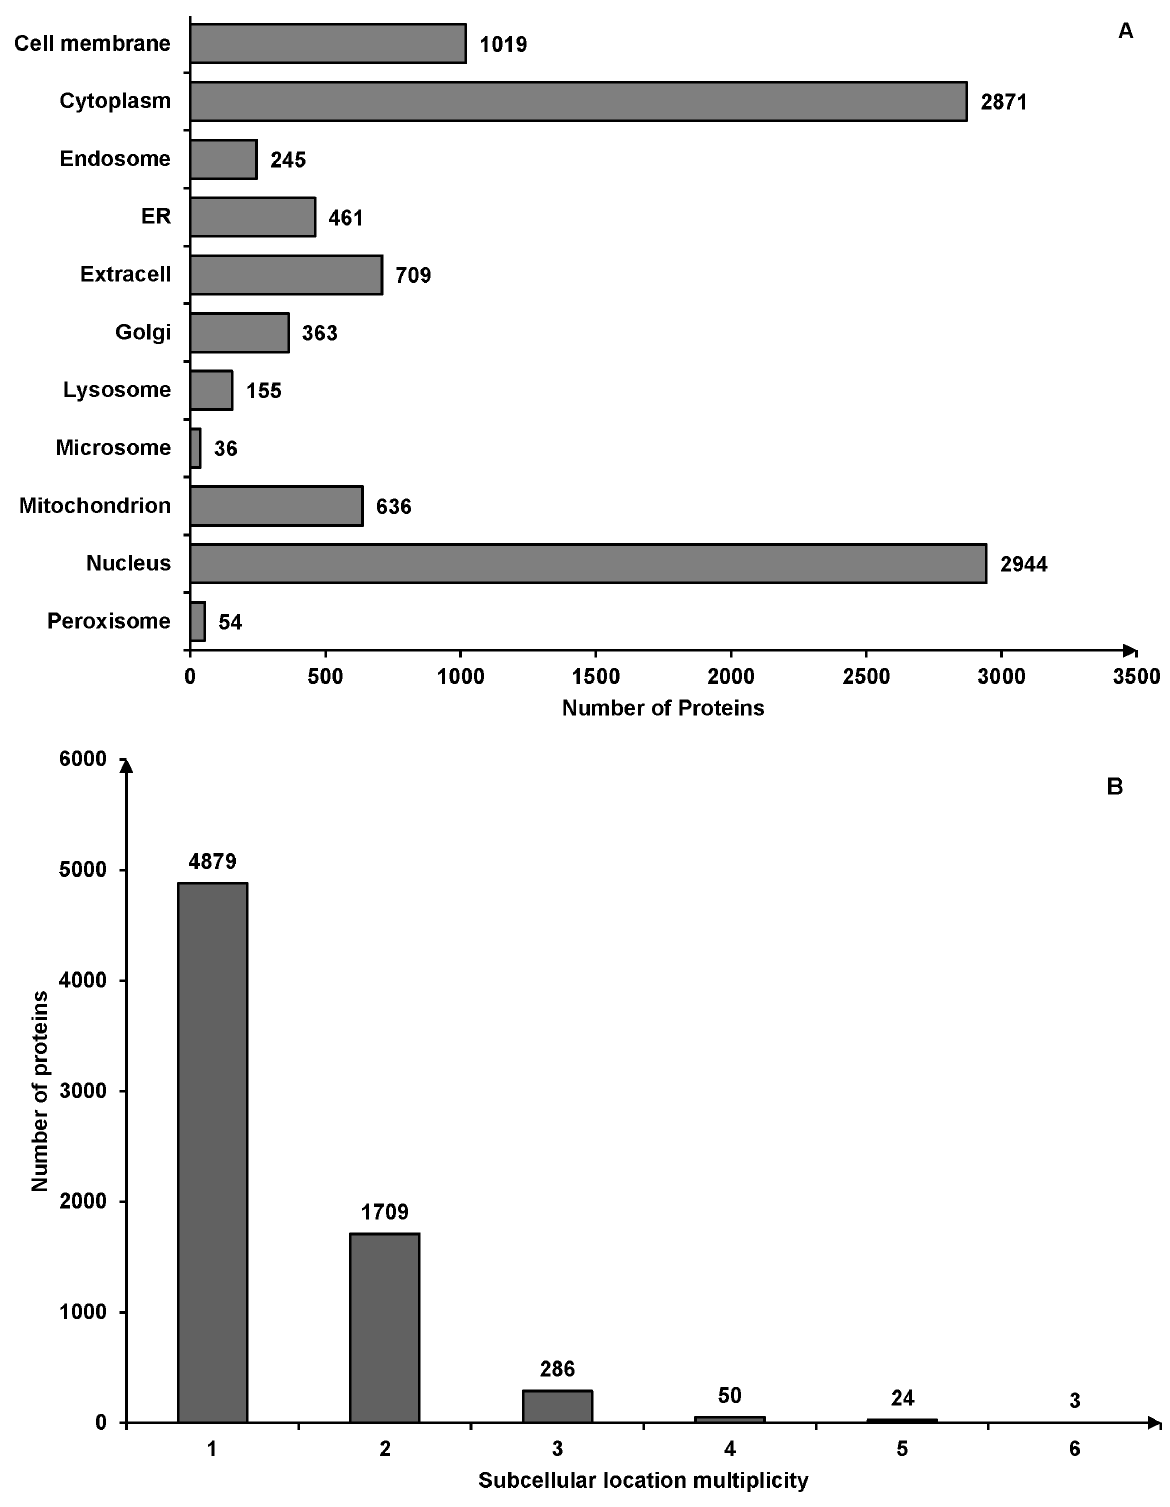
Figure 1. The summary of dataset. (A) The number of locative proteins in different subcellular locations. There are 6951 proteins with experimentally annotated subcellular locations in the dataset. Because one protein may have more than one subcellular location, the number of locative proteins is 9493. (B) The number of proteins with different number of subcellular locations.